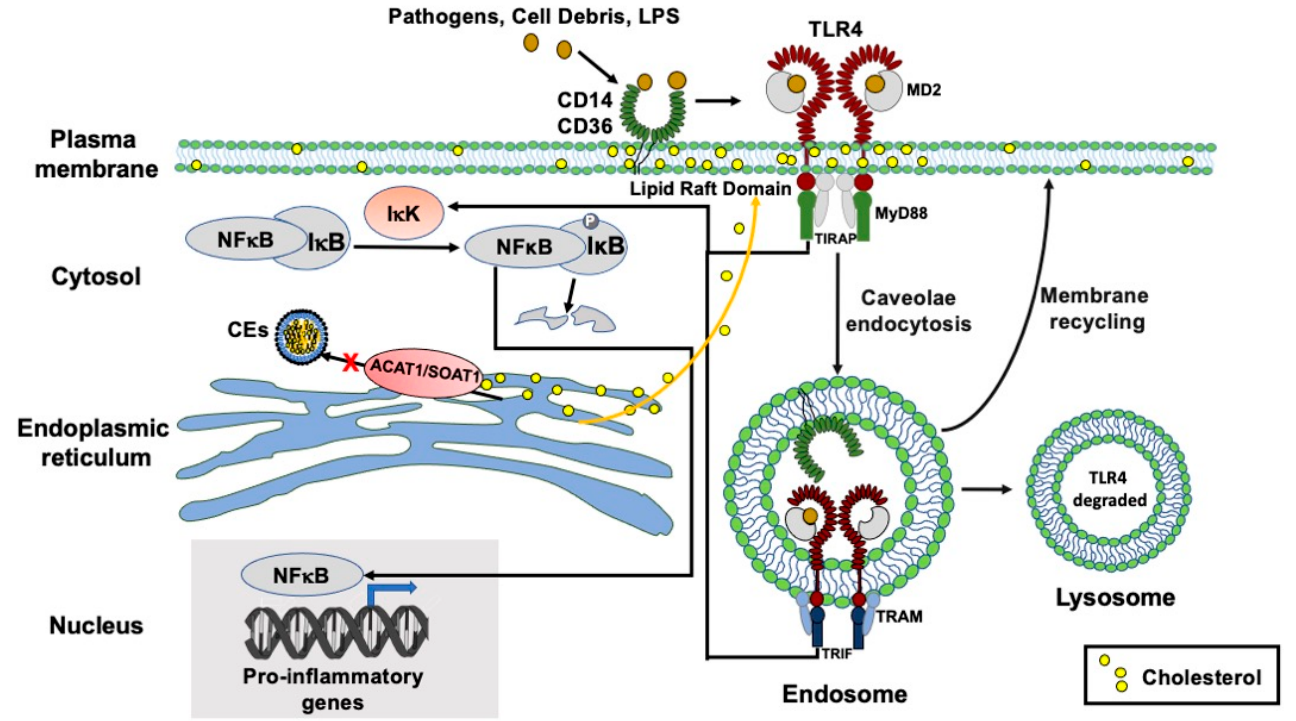
Figure 7. A working model to account for the action of A1B to suppress pro-inflammatory signaling cascade in microglia treated with LPS. At the plasma membrane (PM) of microglia, LPS (or other pathogens/oxidized lipids) binds to the TLR4/MD2 complex (with CD14 or CD36 as coreceptors) to trigger the dimerization of TLR4/MD2 within the lipid raft domain. The adaptor proteins MyD88/TIRAP bound to TLR4/MD2 activate IkK - mediated phosphorylation of I κ B, causing nuclear translocation of NF κ B to activate transcriptions of various pro-inflammatory genes. TLR4/MD2 undergoes caveolae/lipid - raft - mediated endocytosis. This process terminates its pro-inflammatory signaling activities at the PM. ACAT1/SOAT1 is located at the endoplasmic reticulum. In cells acutely treated with LPS, A1B prevents the cholesterol pool from forming cholesteryl esters (CEs) such that it is translocated to the lipid raft domain at the PM and causes TLR4 to undergo caveolae-mediated endocytosis at a more rapid rate. The TLR4/MD2 complex at the endosome can initiate a second pro-inflammatory signaling event that involves similar but different adapter proteins (TRAM, TRIF, etc.). Whether A1B also affects the signaling activity of TLR4/MD2 at endosomes is currently unknown. The TLR4/MD2 complex at the endosome undergoes membrane recycling to return to the PM; it eventually enters the terminal lysosomal compartment to be degraded. In N9 cells, chronically treated with LPS, A1B may act by increasing the residence time of TLR4 in the lysosomes such that more TLR4 becomes degraded.